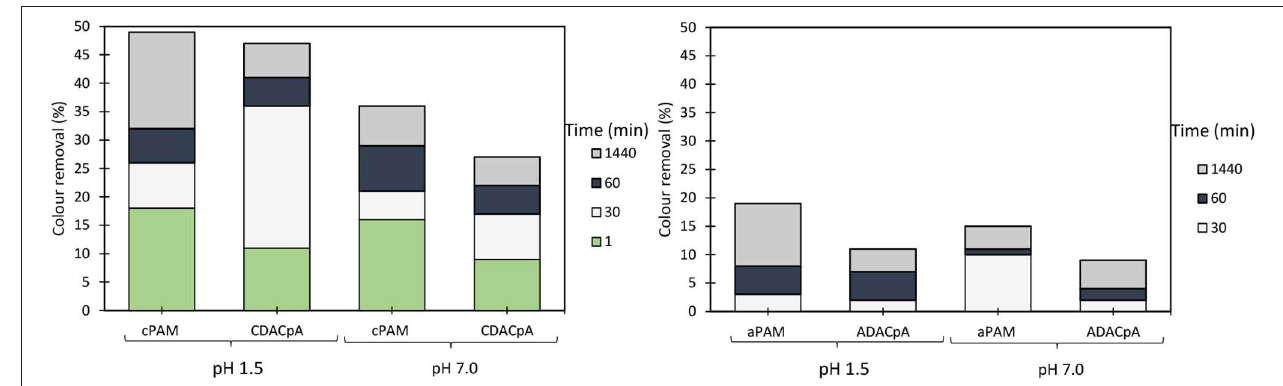
FIGURE 2 | Industrial colored effluent treatment (based on turbidity reduction) using only a single flocculation agent [5.34 mg/L of synthetic (cPAM or aPAM) or cellulose-based (CDAC p A or ADAC p A)] at two different pH levels, 1.5 and 7.0.